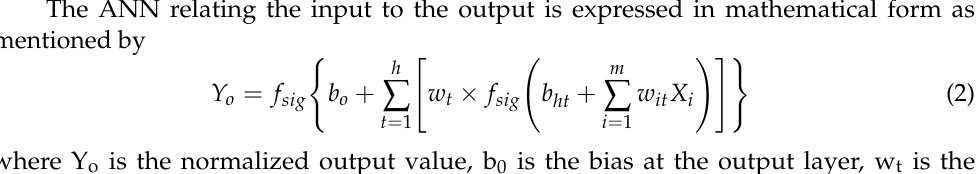
Figure 14. An example showing the calculation of IFA at 45% degree of saturation of the soil. Field vs. ANN results of IFA at different degree of saturation of the soil.